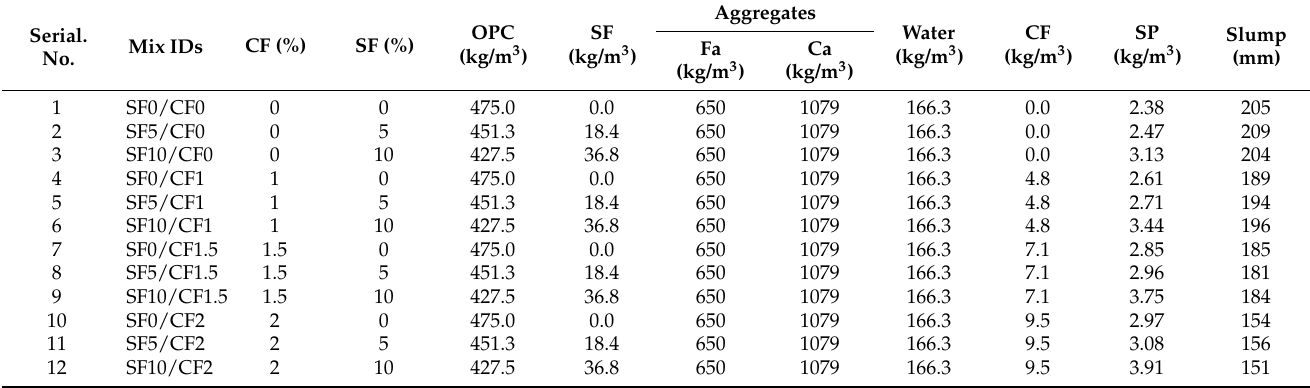
Table 3. Nomenclature and design of mixtures.